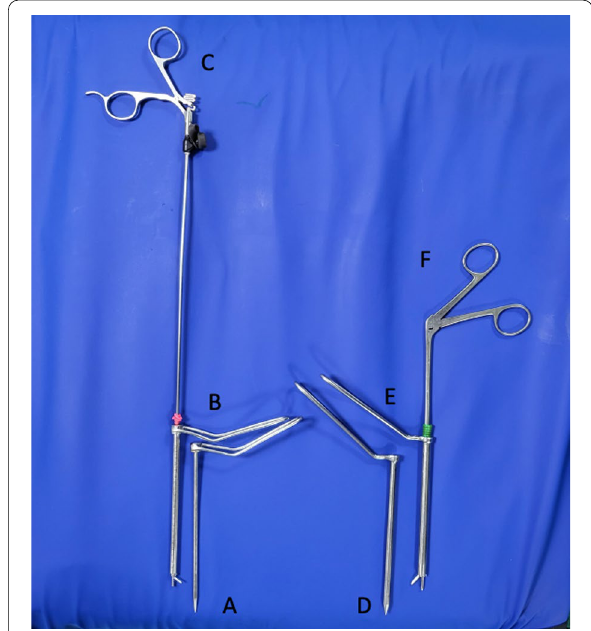
Fig. 2 5 mm Calibrated Biopsy cannula ( B ) with its trocar ( A ) and calibrated endoscopic 2.5 mm grasper ( C ) with Red Stopper working at a pre-decided length. This is used for only diagnostic biopsy